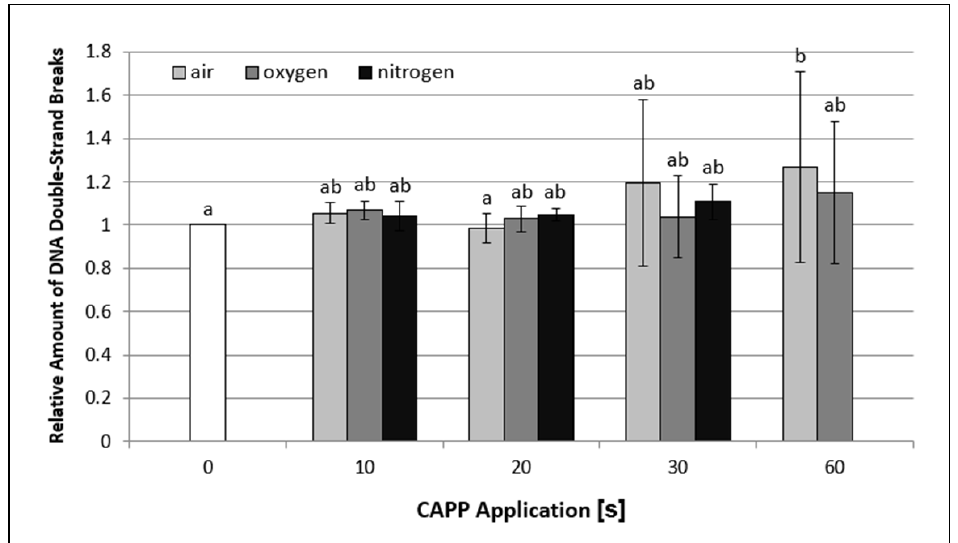
Figure 8. Graphical representation of the CAPP generated in ambient air, oxygen and nitrogen at exposure times of 10–60 s on the degree of double-strand breaks in barley leaves’ DNA, analyzed by constant field gel electrophoresis (CFGE). The data were analyzed using the statistical method LSD ANOVA and comparisons between the mean values were considered significant at p ≤ 0.05. Bars are means of three experimental runs ± SD.